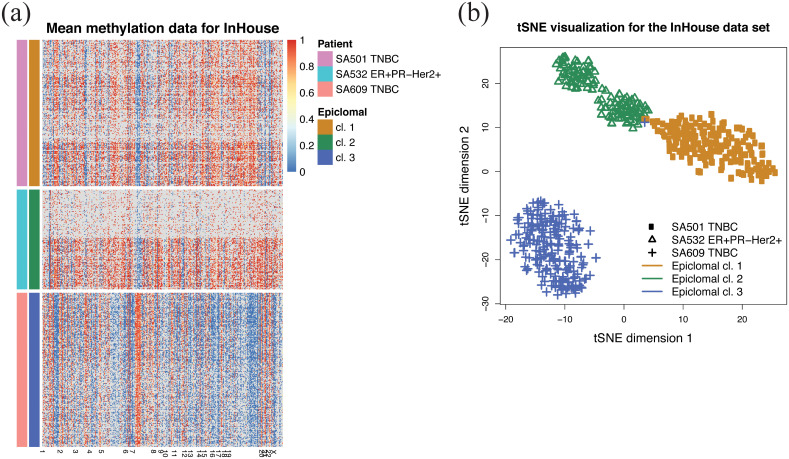
Visualization of the InHouse clusters.(a) EpiclomalRegion clustering, with data filtered to include the most variable CGIs and obtain ≈ 15,000 loci (327 CGIs, cell average missing proportion 0.82, 558 cells). EpiclomalRegion obtained 3 clusters. Rows are cells, and columns are CGIs. (b) tSNE dimensionality reduction and color-coding of the Epiclomal clusters onto the tSNE 2-dimensional space.